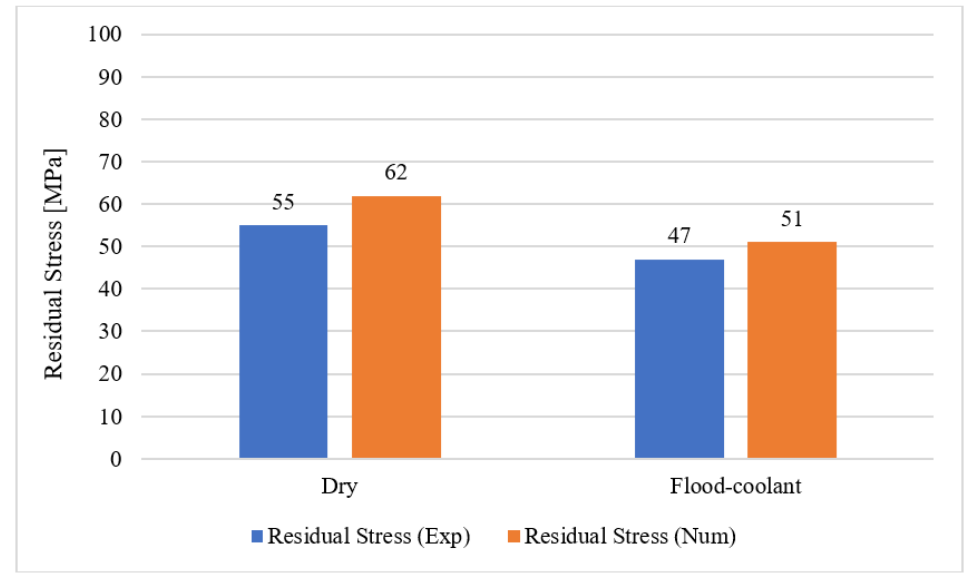
Figure 20. The measured and predicted residual stresses for dry and flood-coolant modes.